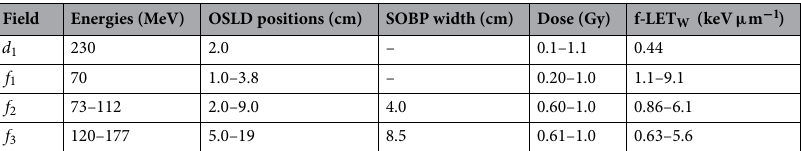
Table 1. The four proton fields used to irradiate the OSLDs at different LETs and doses. The field d 1 was used for the dose calibration at a depth of 2 cm PMMA. For the remaining three fields, OSLD packages were irradiated at different positions along the central axis at ranges given as the column with OSLD positions. f 1 was a 70 MeV single energy layer whereas f 2 and f 3 were spread-out Bragg peaks (SOBPs). The column with OSLD positions denote the depths in PMMA at which the OSLDs were irradiated. The uncertainty estimates are given in the “Proton irradiations”